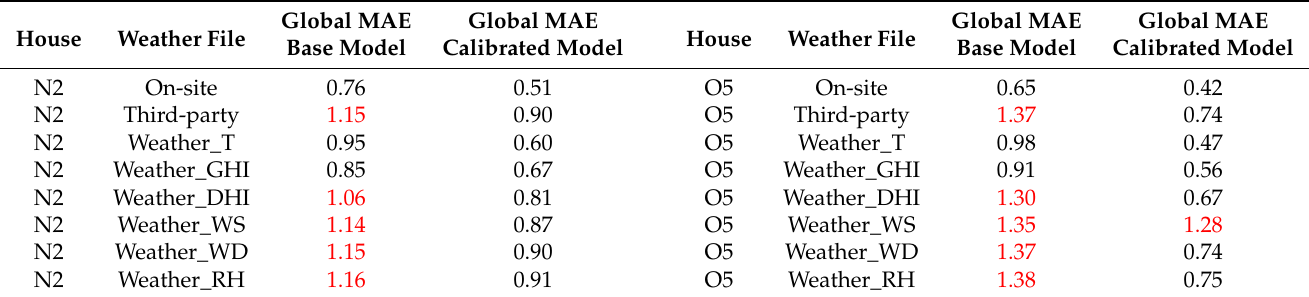
Table 4. Comparison of results between the base and calibrated models in the checking period. The N2 and O5